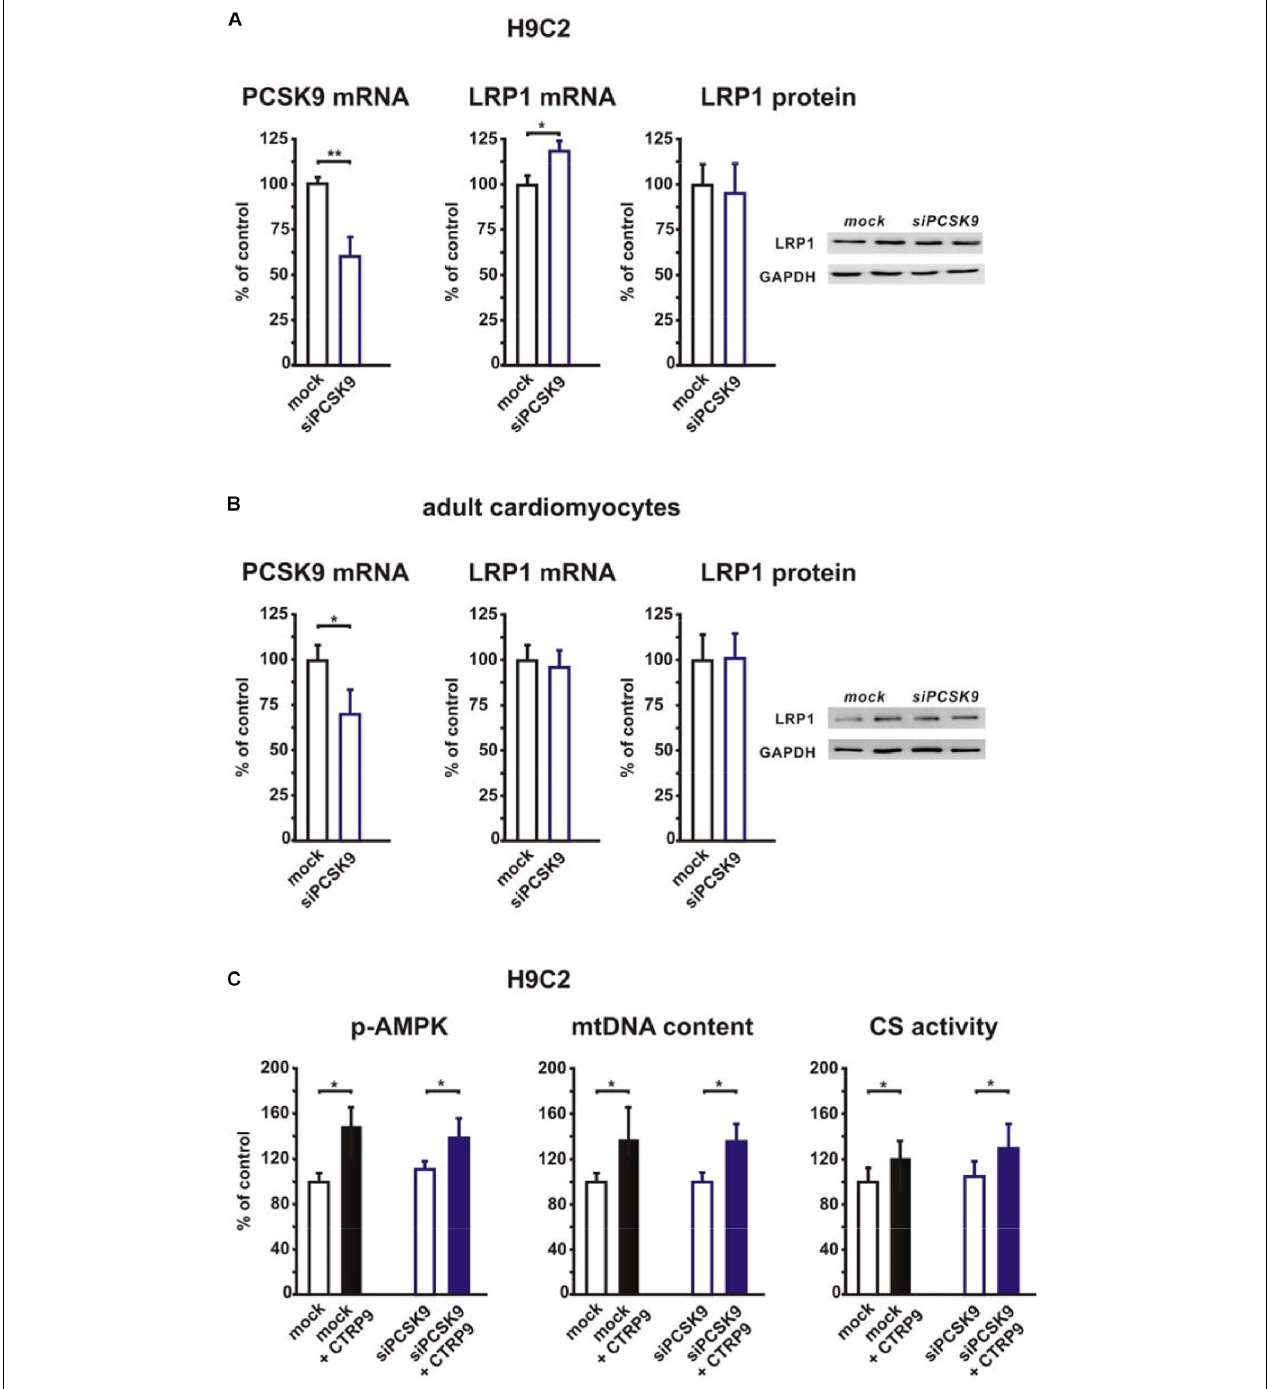
FIGURE 2 | Impact of PCSK9 knockdown on LRP1 expression and CTRP9-induced mitochondrial biogenesis. (A) H9C2 cardiomyoblasts were transfected with siRNA directed against rat PCSK9 or mock siRNA for 48 h. Afterward PCSK9 mRNA, LRP1 mRNA, and LRP1 protein expression were analyzed. mRNA expression of PCSK9 and LRP1 as determined by real-time PCR and densitometry of protein data and representative Western blots for LRP1 and GAPDH are shown. (B) Adult rat cardiomyocytes were incubated with siRNA directed against rat PCSK9 or mock siRNA for 48 h and afterward analyzed for PCSK9 mRNA and LRP1 mRNA or protein expression by real-time PCR or Western blotting. GAPDH served as a loading control. (C) H9C2 cardiomyoblasts were transfected with siRNA directed against rat PCSK9 or mock siRNA for 48 h and thereafter treated with CTRP9 (4 µ g/ml) for the indicated times. Activation of AMPK was analyzed after 20 min stimulation with CTRP9 and mtDNA content and citrate synthase activity after 24 h stimulation with CTRP9 as described in Figure 1 . All data are mean ± SEM, 4 independent experiments, n = 8–16 per group, * p < 0.05; ** p < 0.01.